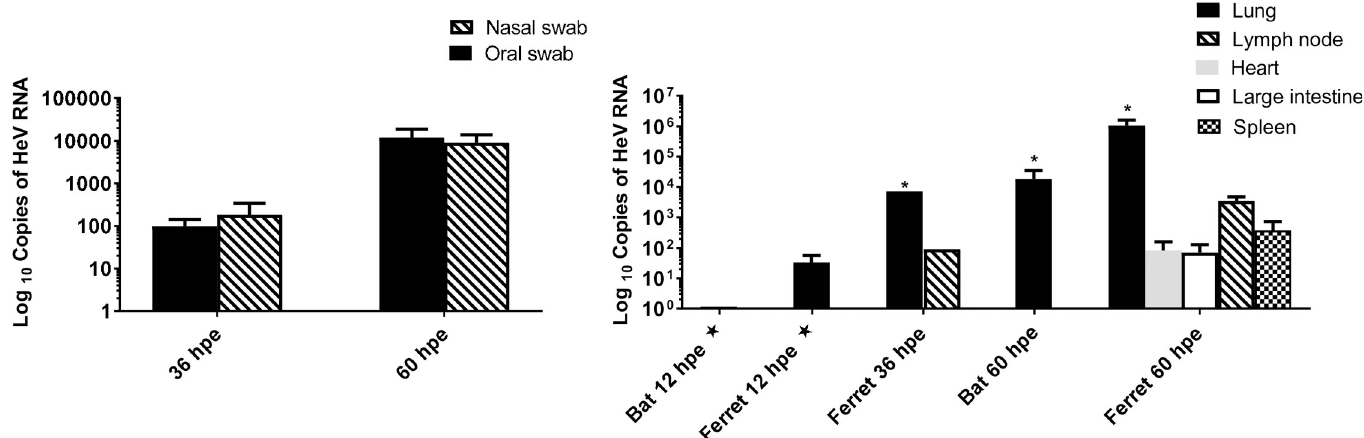
Fig 1. qRT-PCR detection of HeV M gene. ( A ) ferret swabs and ( B ) bat and ferret tissues (median + range). � designates tissues for which virus was re-isolated, $ detections at 12 hpe may be derived from the inoculum.